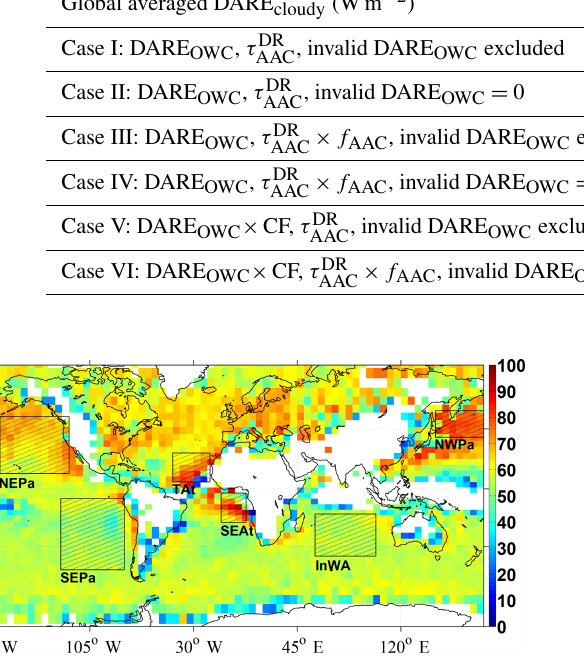
Figure 6. Six regions of high AAC occurrence, further defined in Table 5. Background map is the global annual 4 ◦ × 5 ◦ nighttime AAC occurrence frequency ( f AAC ; see Eq. (3) and Fig. 2 for sea- sonal f AAC maps). Global annual maximum, median and mean f AAC values are respectively 93%, 57% and 57%.